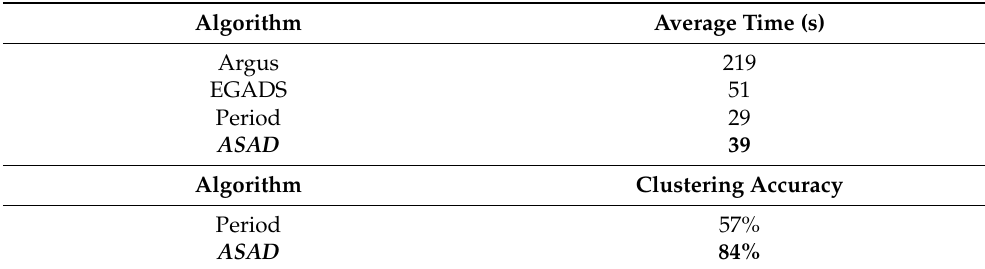
Table 9. Time and performance